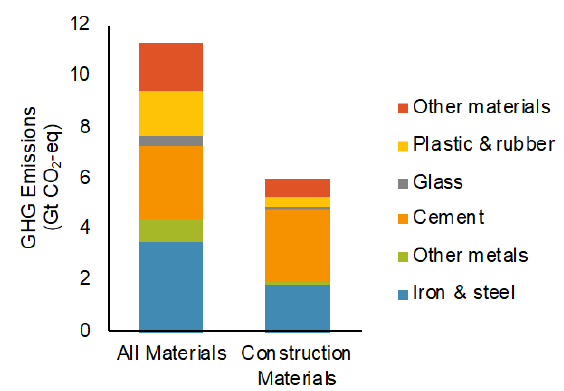
Figure 1. Approximate global greenhouse gas emissions from all materials production and construction materials production in 2016. Emissions from materials production based on data from [14]; fraction of iron and steel in construction based on data from [16]; fraction of cement in construction based on data for US from [15]; fraction of plastics in construction based on data from [17]; all other material fractions used in construction based on data from [14]. Note: emissions from materials production are from [14], and do not reflect all emissions reported by the Intergovernmental Panel on Climate Change (IPCC)